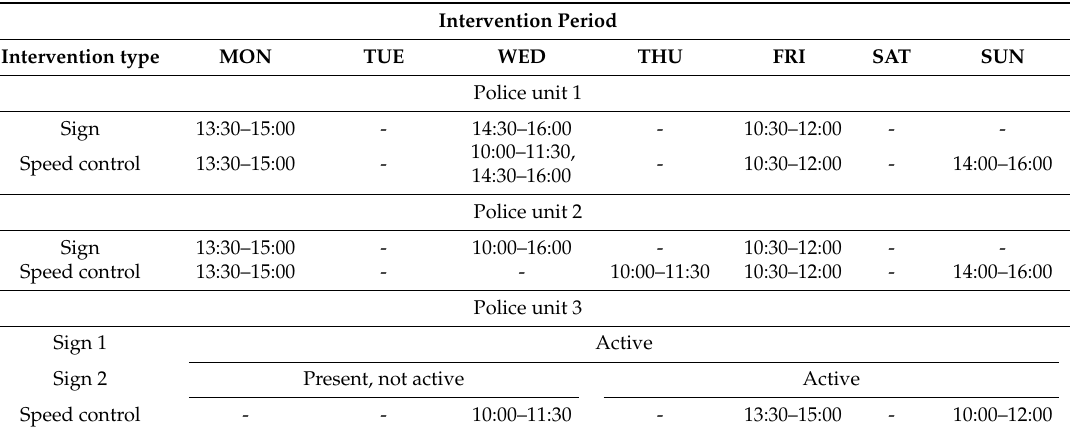
Table 2. Intervention scheme for each regional police